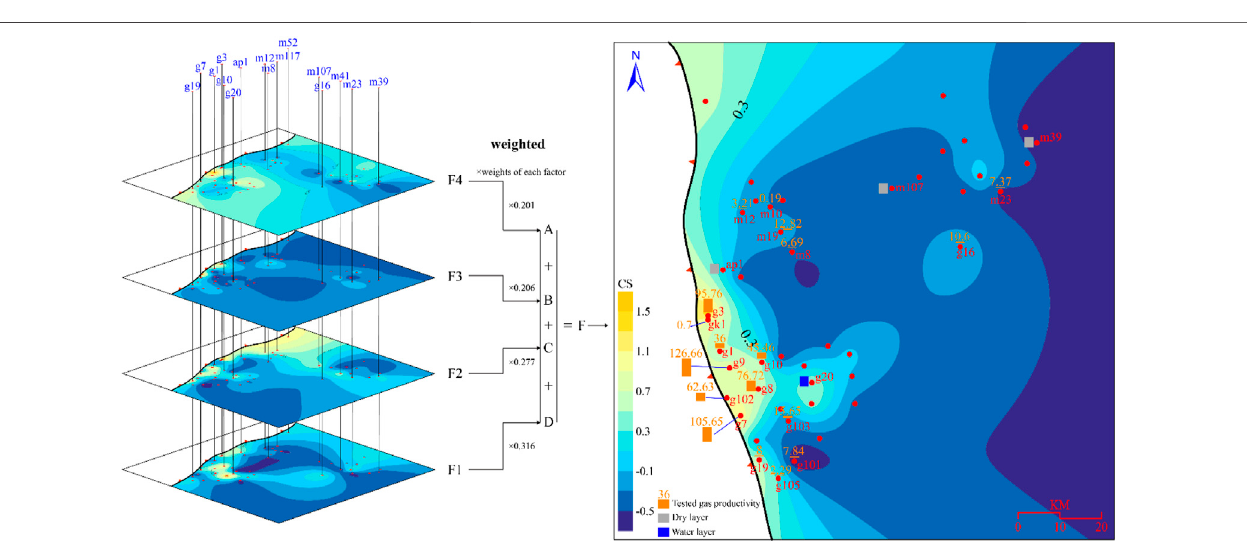
FIGURE 5 | Comprehensive evaluation of reservoirs of Z 2 dn 4 via factor analysis for the 11 characteristic parameters. Note the right panel, in which the tested gas productivities are superimposed on the comprehensive evaluation map and show a well-coupled matching with the comprehensive scores. CS-comprehensive score,